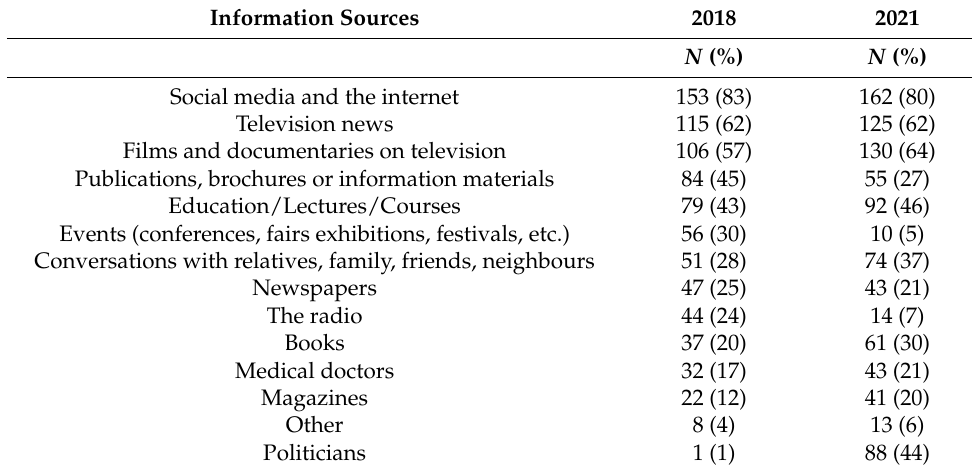
Table 2. Preferred information sources used to receive information regarding environmental health risks to the 2018 and 2021 survey question: “Choose up to five sources of information where you get information about environmental health risks from”.